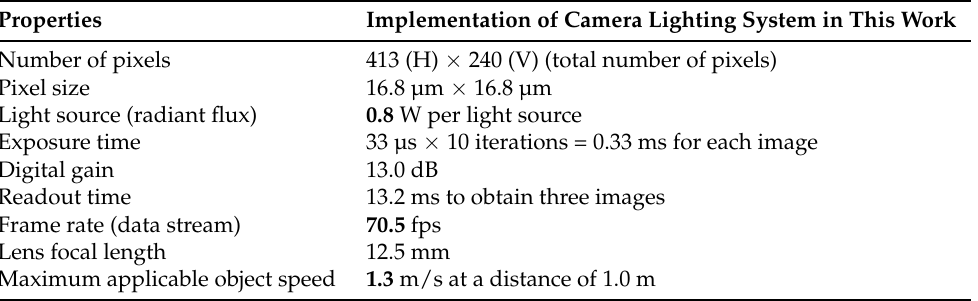
Table 1. Detailed specifications of the implemented camera lighting